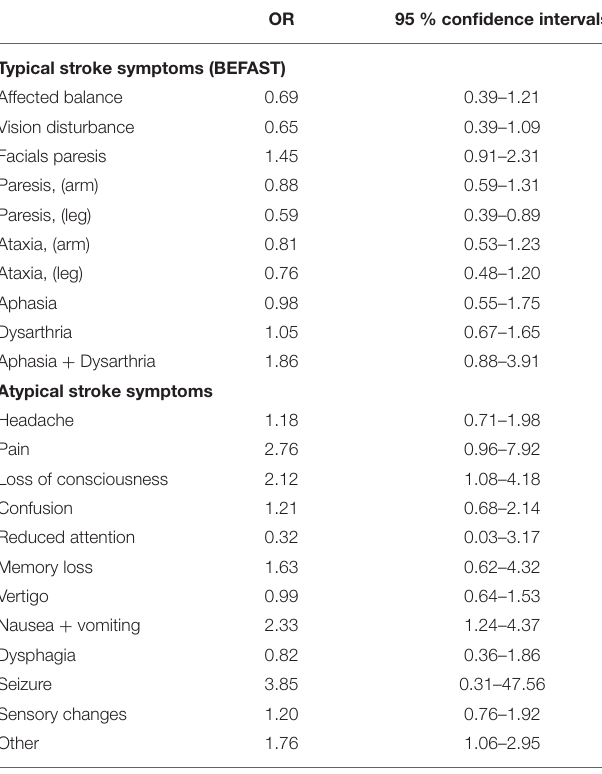
TABLE 3 | Sex-related differences in patient-reported stroke symptoms (continuous). OR 95 % confidence intervals